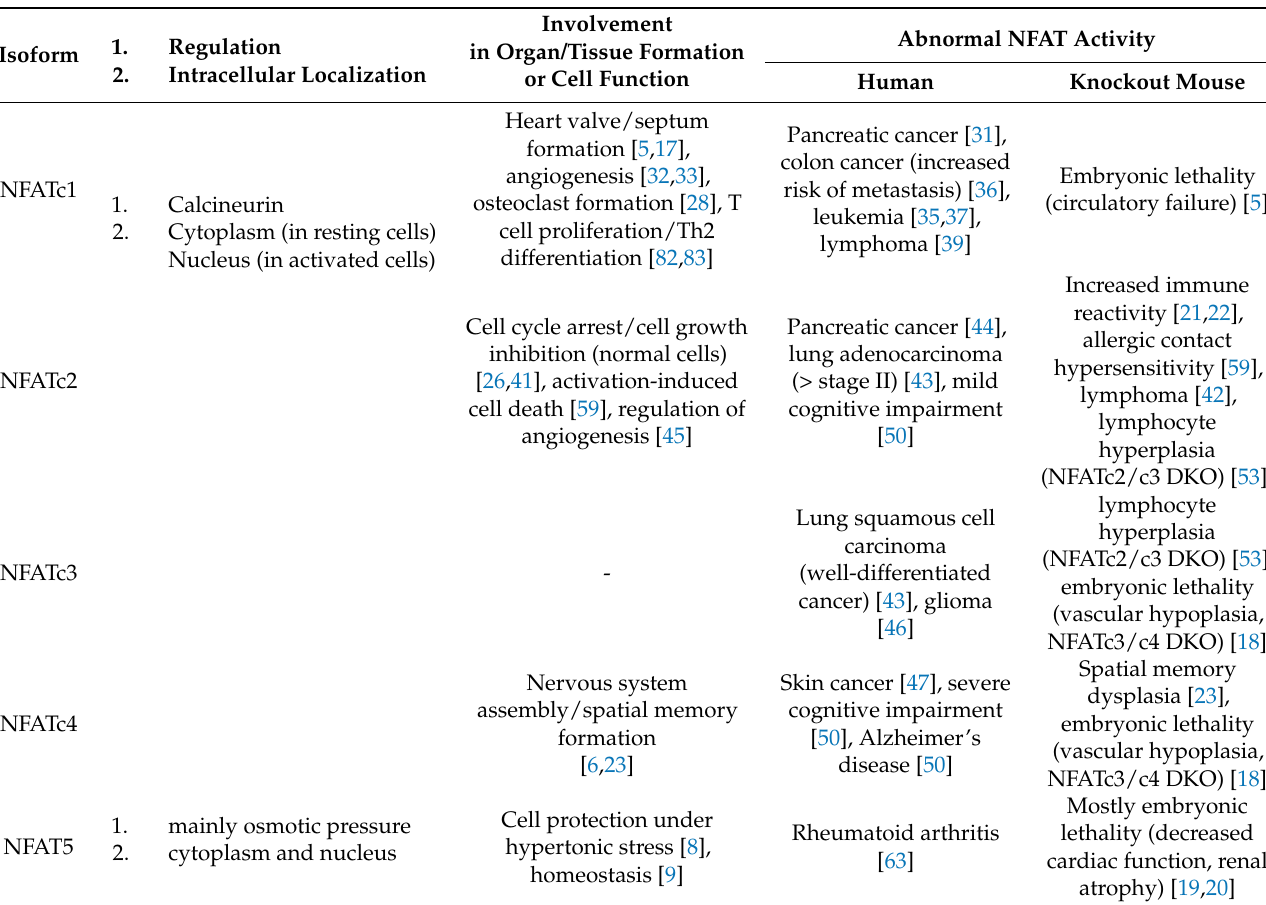
Table 1. Functions and diseases associated with NFAT family